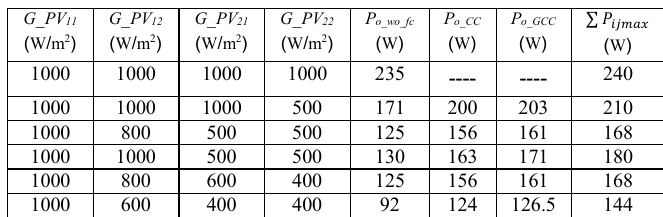
MPP P OWER OF PV A RRAY UNDER VARIOUS I RRADIANCE CONDITIONS FOR CC AND GCC METHOD